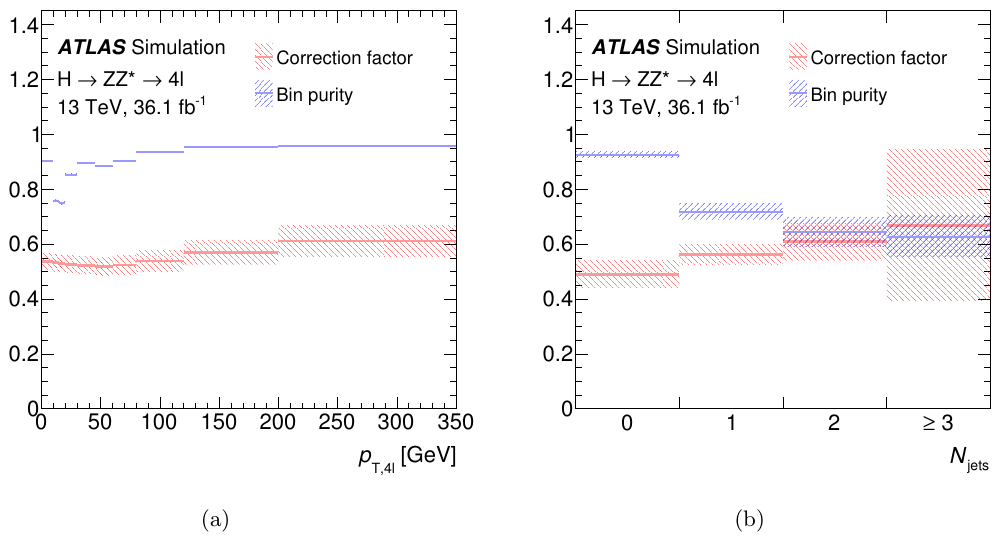
Figure 6. Bin-by-bin correction factors and bin purities for (a) the transverse momentum of the four leptons p T ; 4 ‘ and (b) the number of jets N jets . The bands show the systematic uncertainties in the correction factors, which are discussed in section 9. The uncertainties in the bin purity include the detector response and pile-up uncertainties.